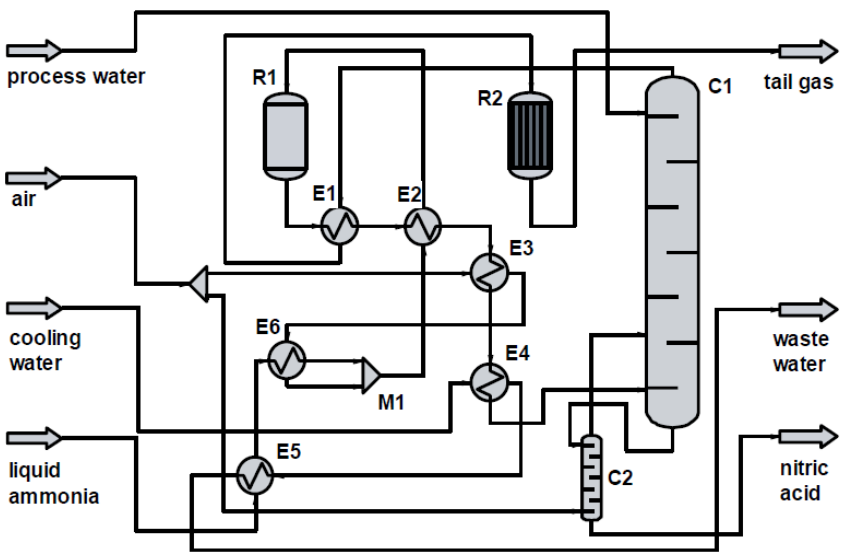
Figure 9. Scheme of the pilot plant. Symbols: C1 — absorption column, C2 — bleaching column, E1 – E6 — heat exchangers, M1 — air – ammonia mixer, R1 — ammonia oxidation reactor, R2 — selective